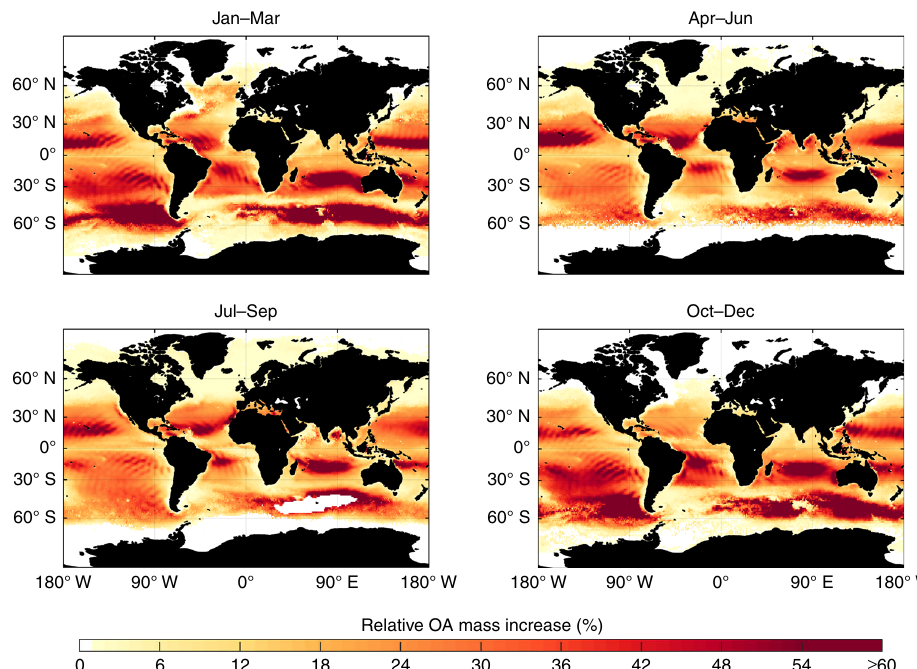
Fig. 5 Seasonal estimates on the organic aerosol mass contribution in the marine boundary layer from oxidation of photochemically produced VOCs for an SML wind speed limit of 13 m s – 1 . For wind speed limits of 8 and 10 m s – 1 , see Supplementary Figs 5 and 6. Here, only OH oxidation of unsaturated volatile organic compounds was taken into account, assuming similar secondary organic aerosol yields as given by Tsimpidi et al.